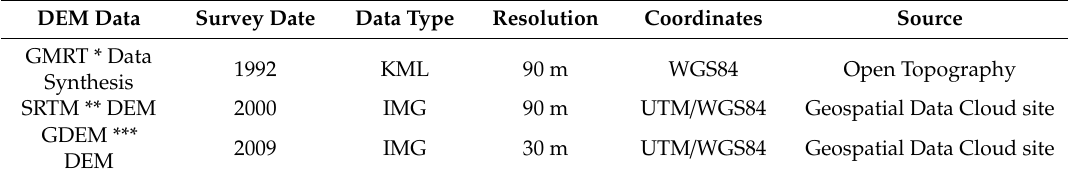
Table 1. Digital elevation model (DEM) data used in this study and their sources.